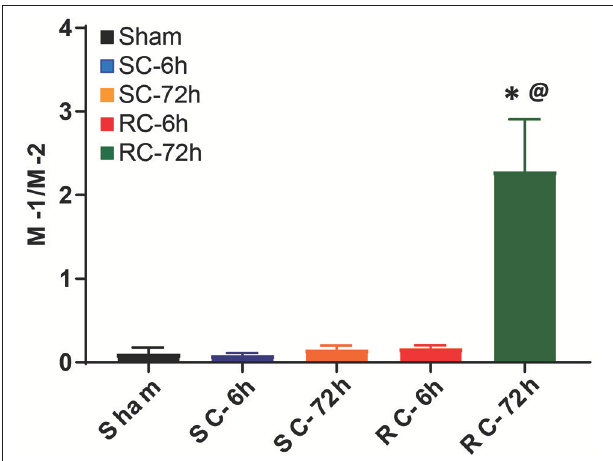
FIGURE 9 | M-1 to M-2 microglial ratio in the ipsilateral cortex. M-1/M-2 ratio lower than 1 favored anti-inflammation, as observed in in sham group and in both SC and RC groups at 6h. M-1/M-2 ratio > 1 supported inflammatory environment, evident in RC group 72h group. One-way ANOVA with Tukey’s post-hoc test.* p < 0.05 compared to single hit 6h. @ p < 0.05 compared to repeated hit. SC: single concussion, RC: repeated